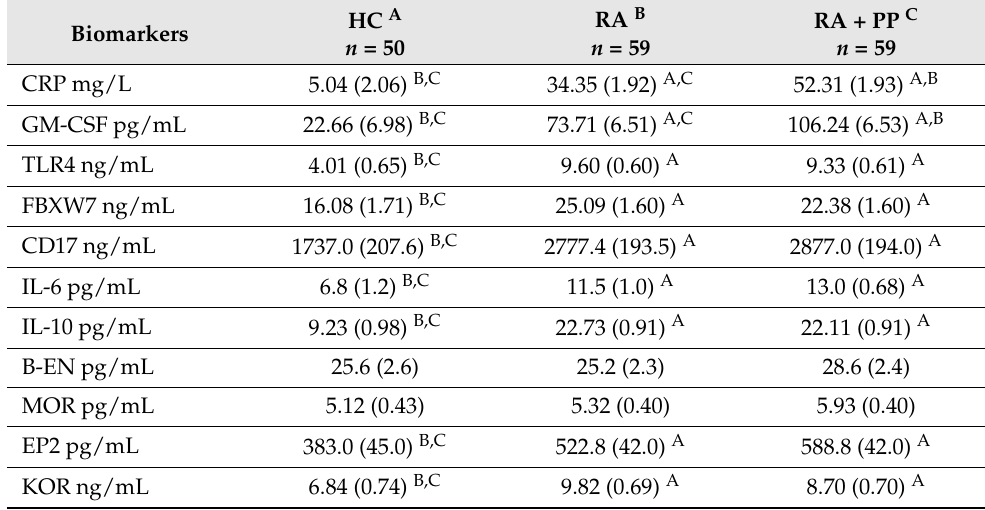
Table 3. Model-generated estimated marginal means values (SE) of the biomarkers in healthy controls (HC) and patients with rheumatoid arthritis (RA) divided into those with (RA + PP) and without (RA) increased psychopathology